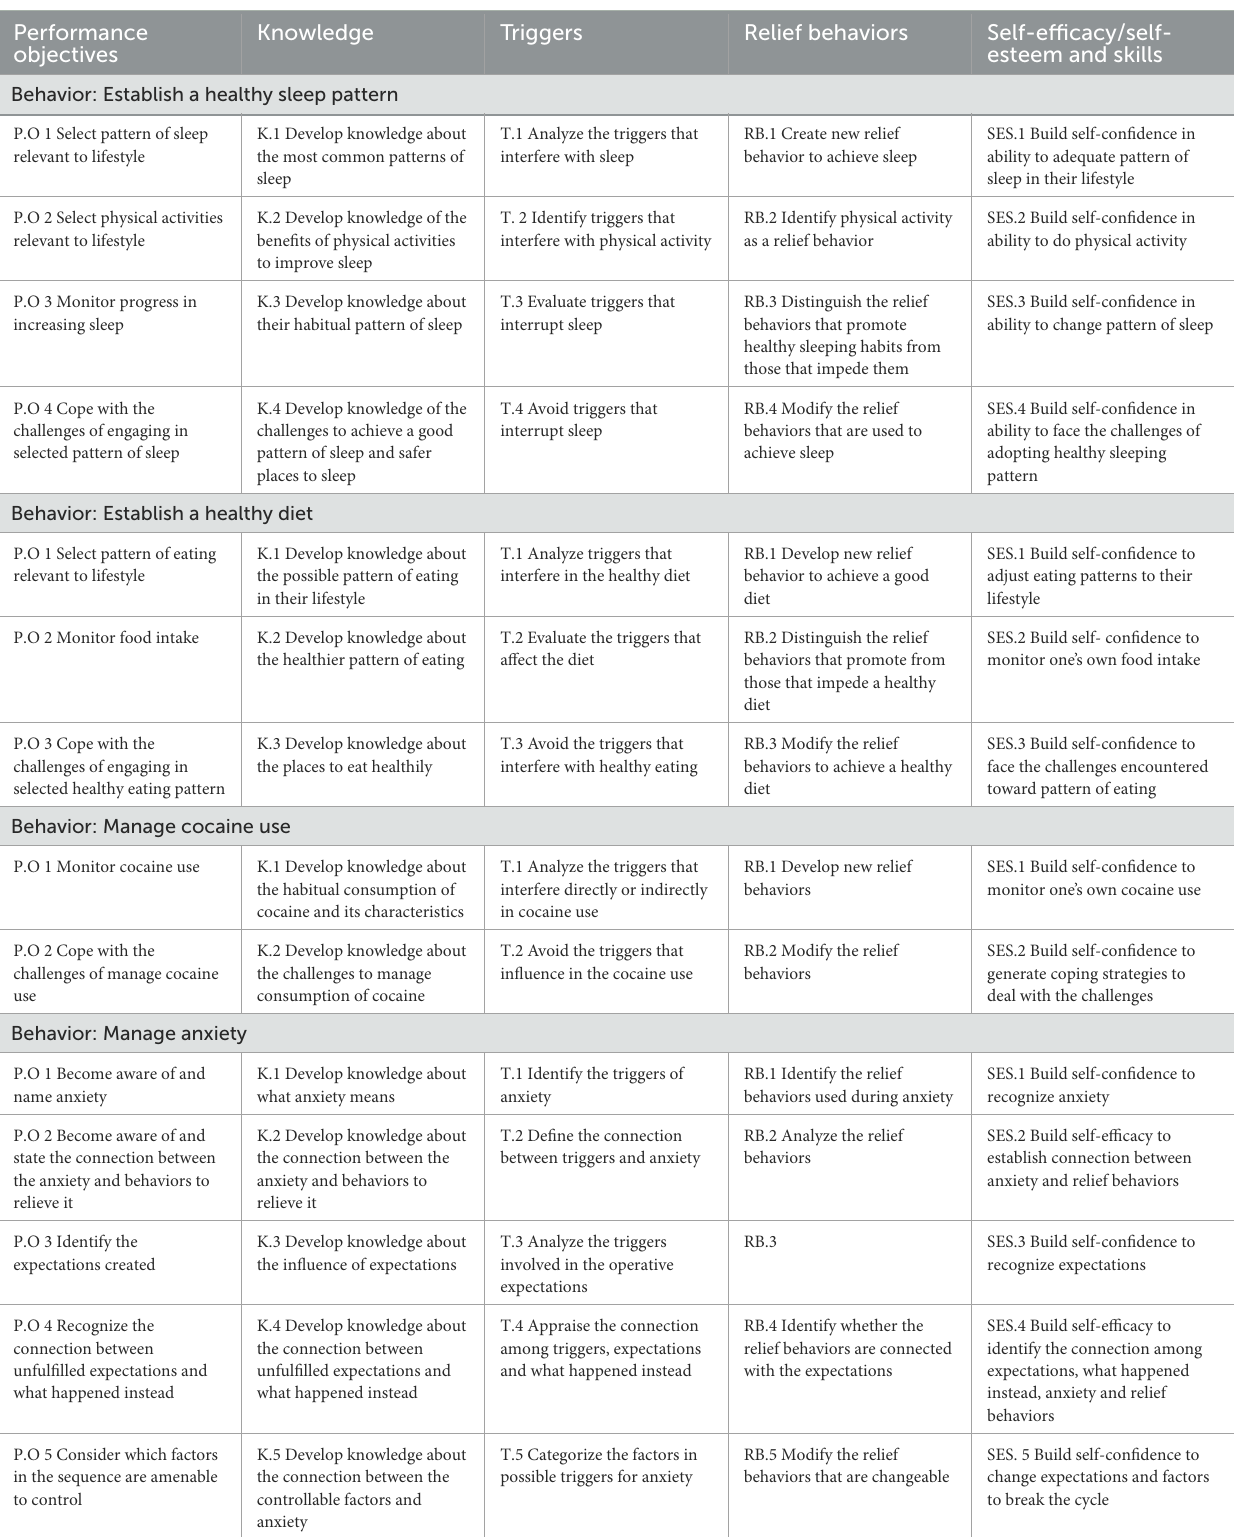
TABLE 1 Matrices construction of change